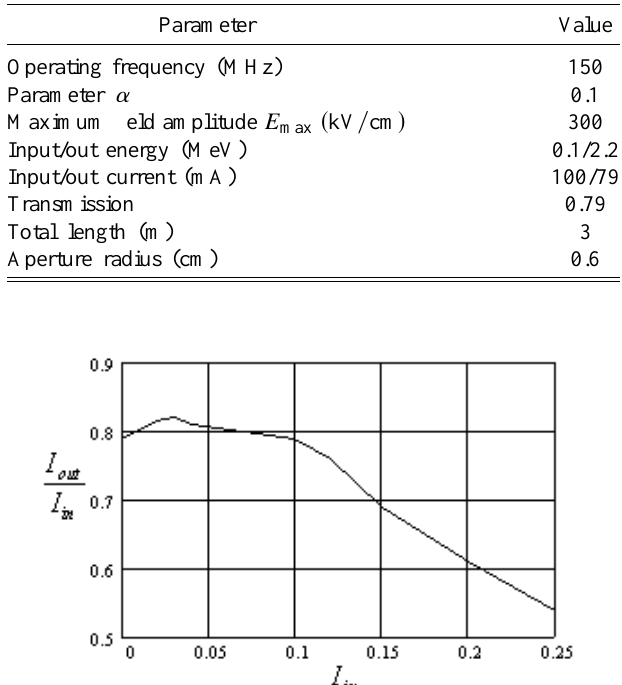
TABLE I. Computer simulation results.